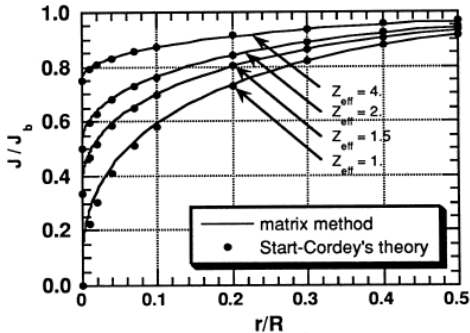
Figure 22. Stacking factor F for neutral beam current drive as a function of r/R and Z [109] in comparison with Calculation by Start-Cordey eff